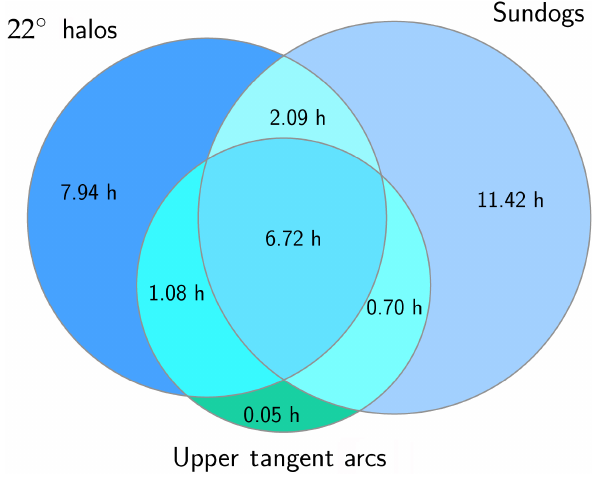
Figure 3. Halo display statistics from HaloCam observations dur- ing the ACCEPT campaign 10 October–14 November 2014. The observation times of 22 ◦ halo, sundogs and upper tangent arc are provided in hours and are represented by the radii of the three cir- cles. Cross sections of circles indicate time periods when two or three halo displays were visible simultaneously. The total observa- tion time amounts to